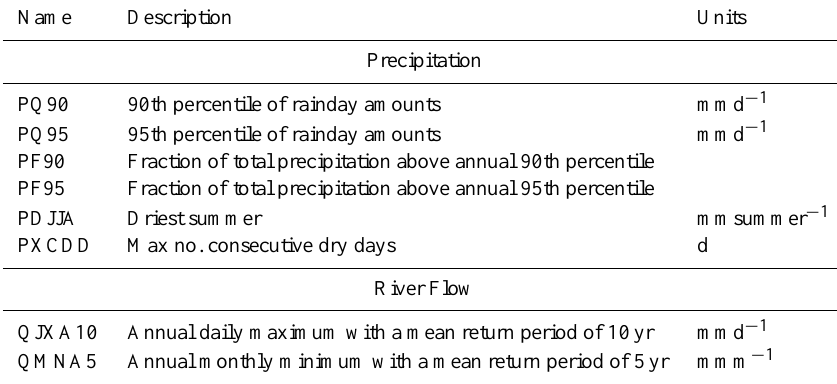
Table 2. Indices of extremes of precipitation and